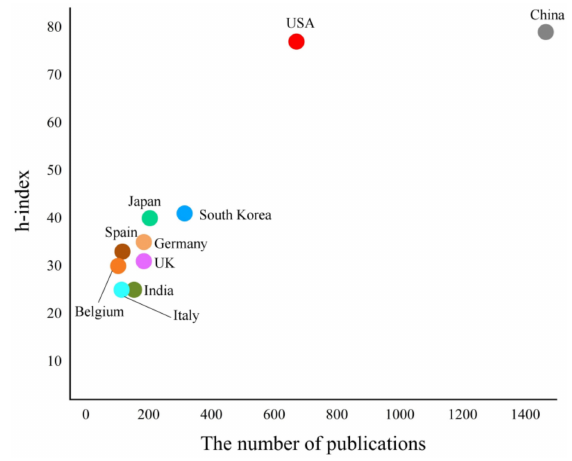
Figure 2. The performance of the top 10 representative countries (TP >